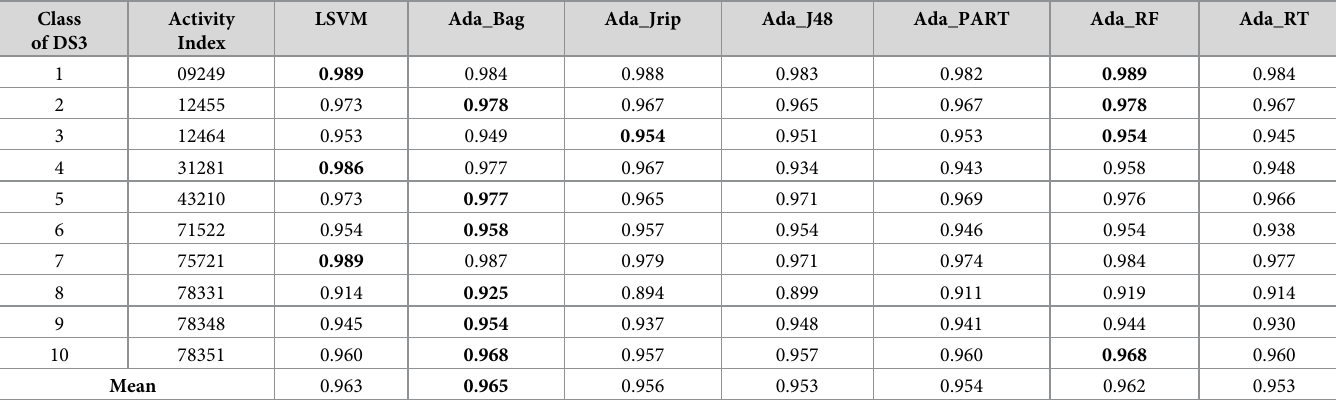
(Table 10 –DS1) outperformed the existing best classifier (LSVM). Furthermore, Table 11 (with DS2) illustrates that 4 (Ada_Bag, Ada_J48, Ada_RF and Ada_RT) out of 6 AdaBoost classifiers outperformed the LSVM classifier. Table 12 (with DS3) illustrates that there was 1 (Ada_Bag) out of 6 AdaBoost classifiers that surpassed the LSVM classifier for AUC measurements. From the results illustrated in Tables 4–12, for all three measures (sensitivity, specificity and AUC), it can be seen that in most cases the AdaBoost ensemble classifiers provided better outcomes when compared with LSVM; these ensemble methods built a sequence of base mod- els where each model was constructed based on the performance of the previous model on the training set. In other words, by suitably combining the results of a set of base classifiers, the performance obtained was better than that of any base classifier. This study used a cut-off value of 0.05 for the significance level (p-value). The p-value was considered significant and capable of providing an overall ranking if p < 0.05 and the critical value for chi-square χ 2 at p = 0.05 for 6 degrees of freedom was 12.59. The degrees of freedom are equal to the total number of algorithms minus 1. In this study, there were 7 algorithms applied (LSVM + six AdaBoost ensemble classifiers), leading to 6 degrees of freedom. The results of Kendall’s W tests are presented in Tables 13–15 (below). Table 12. AUC measure for the prediction of new bioactive molecules with DS3 (heterogeneous). Class of DS3